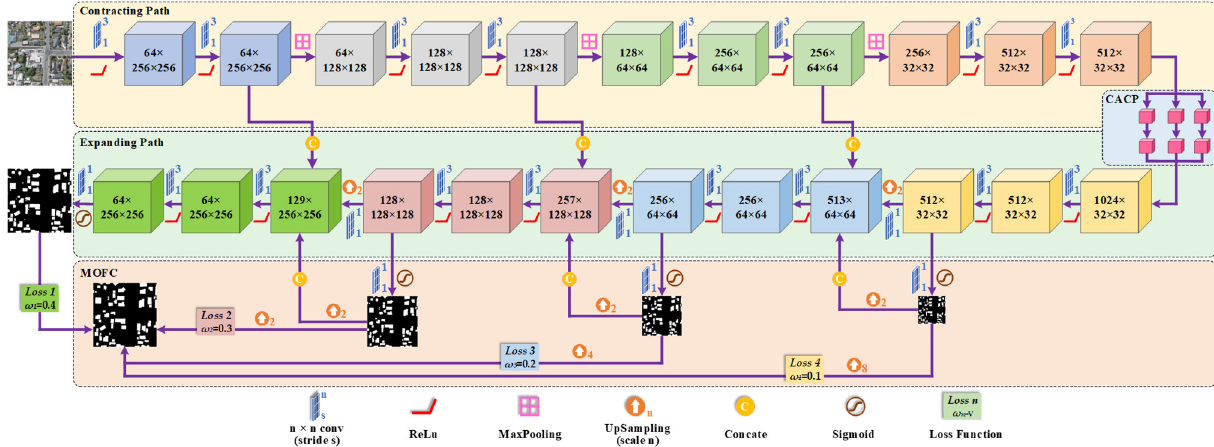
Figure 2. The overall structure of the proposed building multi-feature fusion refined network (BMFR-Net). The upper part is the contraction path, the middle part is the expanding path, the bottom part is the MOFC structure, and the right part is the CACP module.